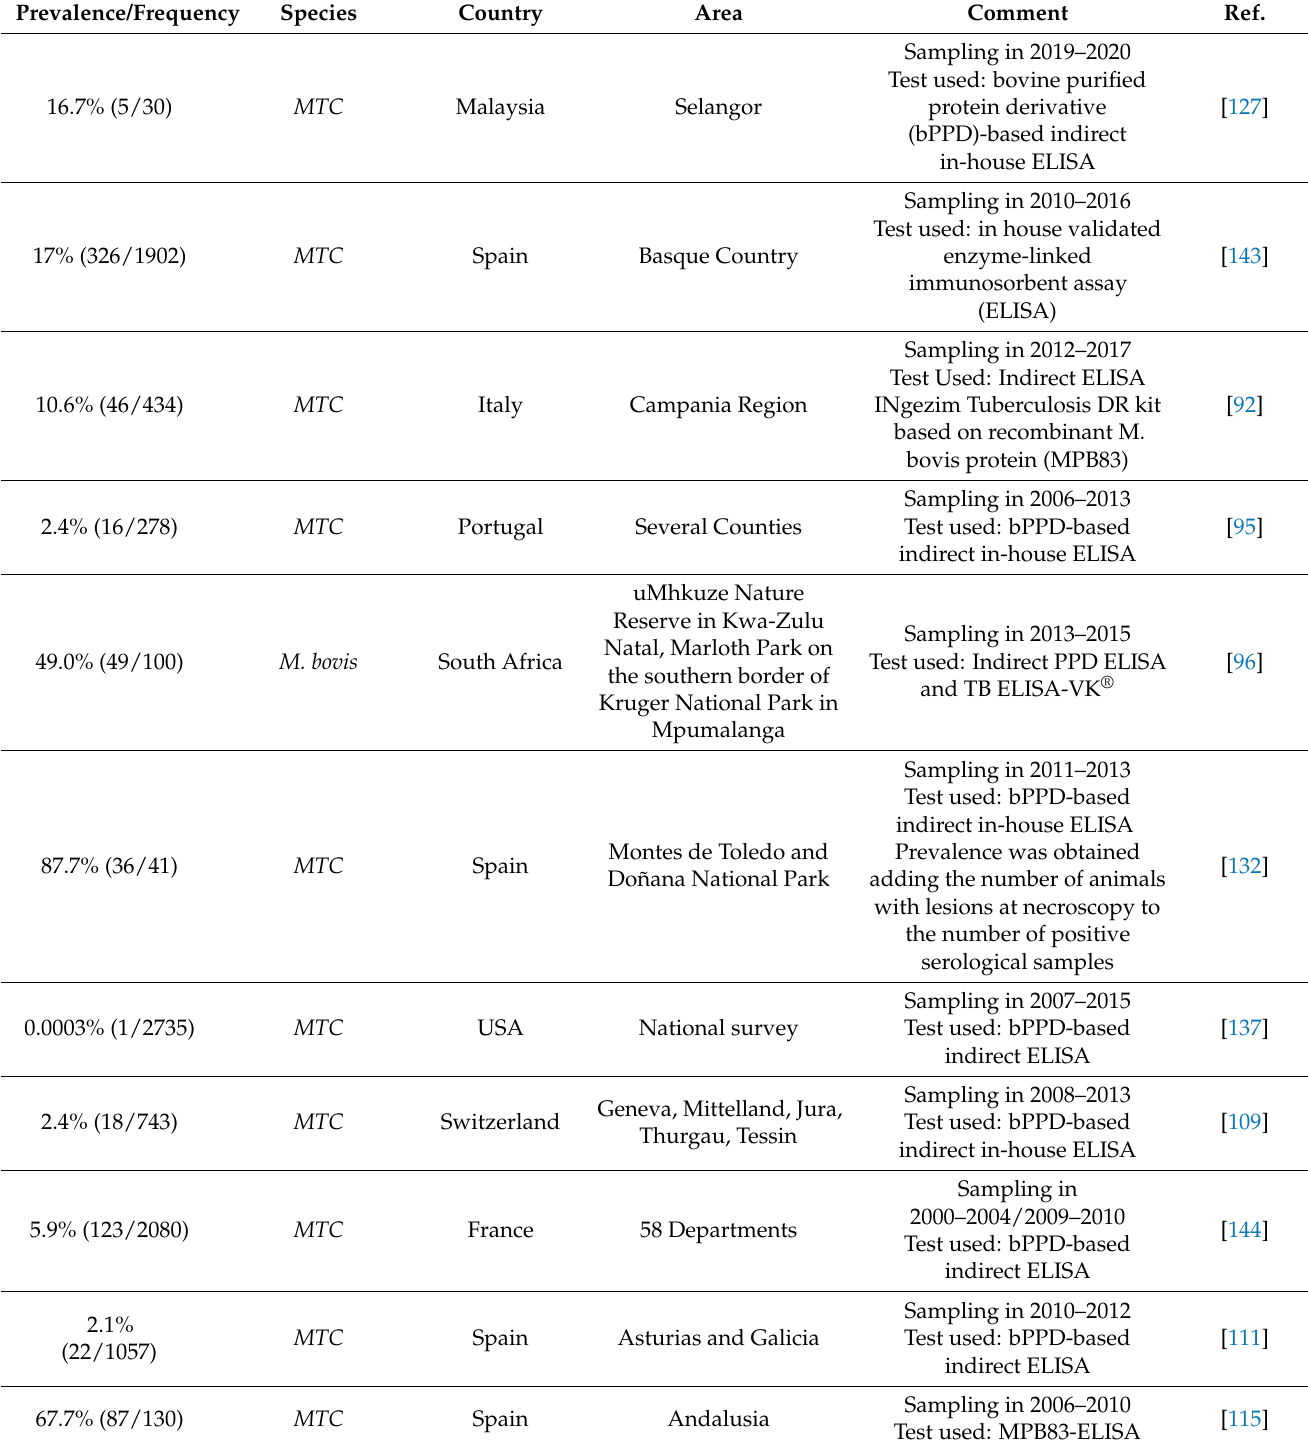
Table 7. Seroprevalence of MTC in wild boar, feral pigs, and warthogs, 2012–2022.